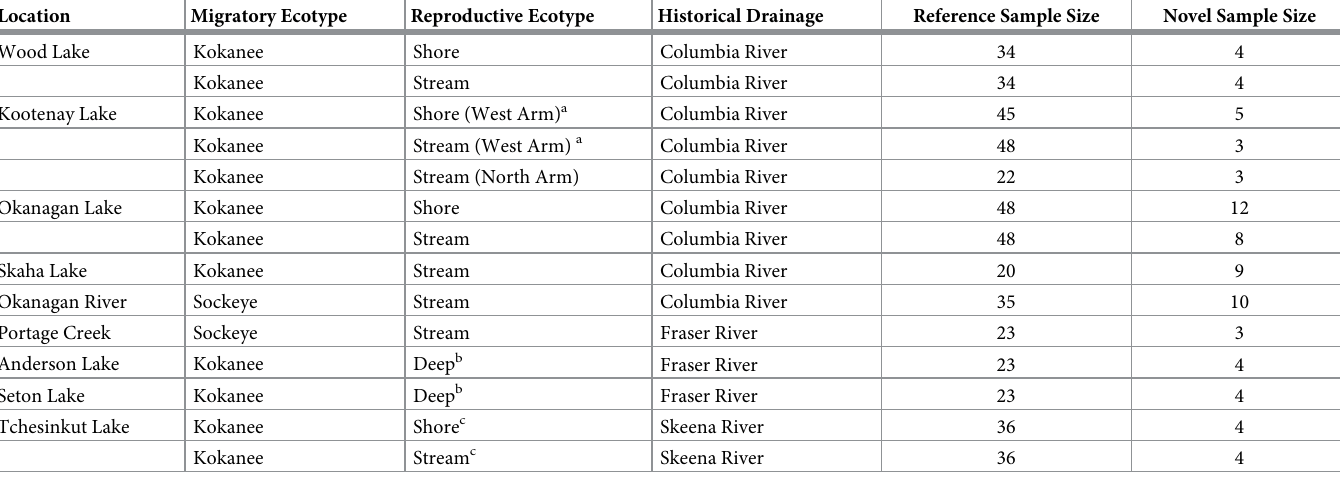
Table 1. Kokanee and anadromous sockeye salmon samples used for assignment to migratory form and reproductive ecotypes across historical drainages.